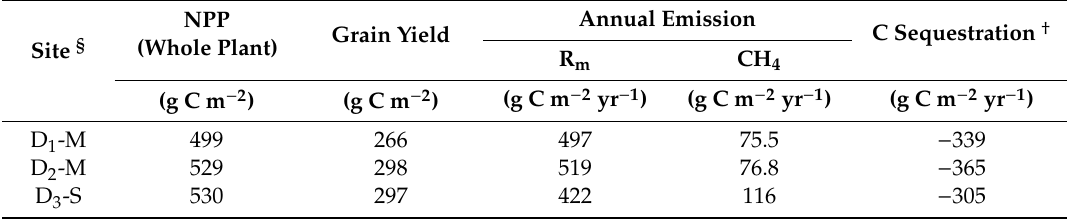
Table 5. Annual C sequestration from paddy-fallow cropping systems.